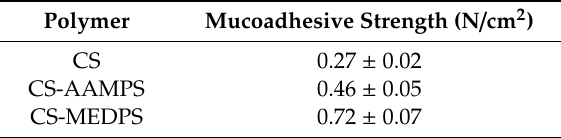
Table 2. Mucoadhesive strength of CS and its